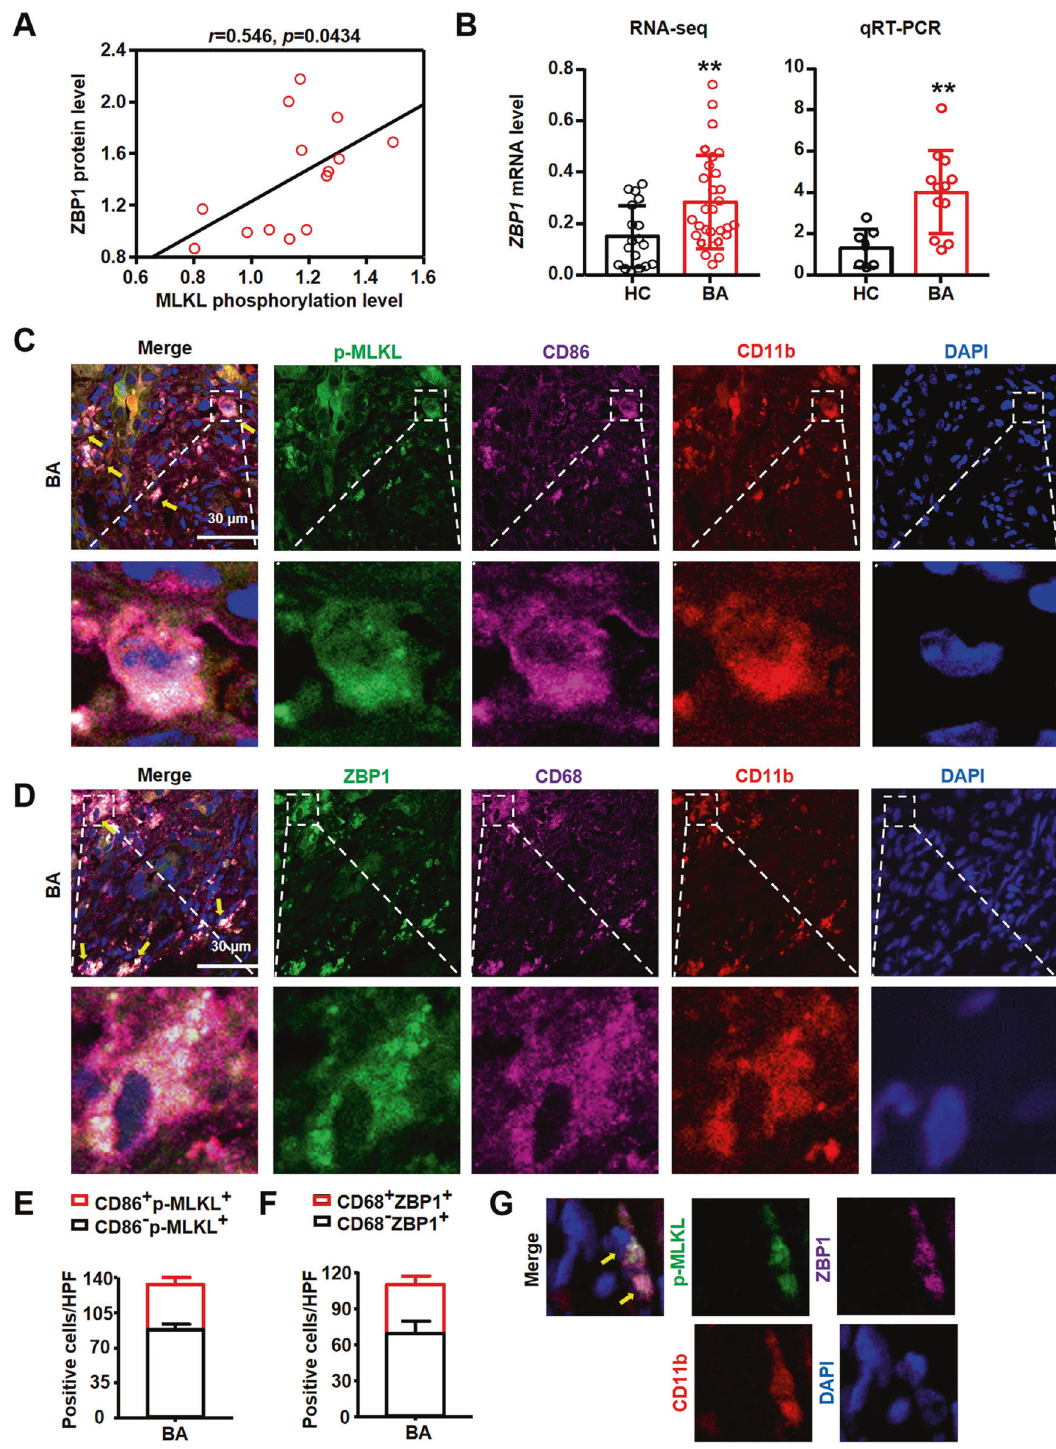
Fig. 2 ZBP1/p-MLKL mediated necroptosis existed in macrophages in BA livers. A The correlation between ZBP1 and p-MLKL in human liver tissues. B Hepatic ZBP1 mRNA level detected by RNA sequencing and qRT-PCR were compared between biliary atresia (BA, RNA-seq: n = 31, qRT-PCR: n = 12) and normal adjacent non-tumor livers (HC, RNA-seq: n = 20, qRT-PCR: n = 7). C Representative images of p-MLKL (green), CD86 (pink) and CD11b (red) staining. The nuclei were stained with DAPI (blue). Yellow arrows: p-MLKL + CD86 + CD11b + cells. Scale bar: 30 μ m. D Representative images of ZBP1 (green), CD68 (pink) and CD11b (red). The nuclei were stained with DAPI (blue). Yellow arrows: ZBP1 + CD68 + CD11b + cells. Scale bar: 30 μ m. E , F Quantitative results of p-MLKL + ( E ) and ZBP1 + ( F ) macrophage number in BA livers. G Representative images of p-MLKL (green), ZBP1 (pink) and CD11b (red) staining in BA livers. The nuclei were stained with DAPI (blue). Yellow arrows: p-MLKL + ZBP1 + CD11b + cells. Data are presented as the mean ± SEM. ** p < 0.01 (versus control).